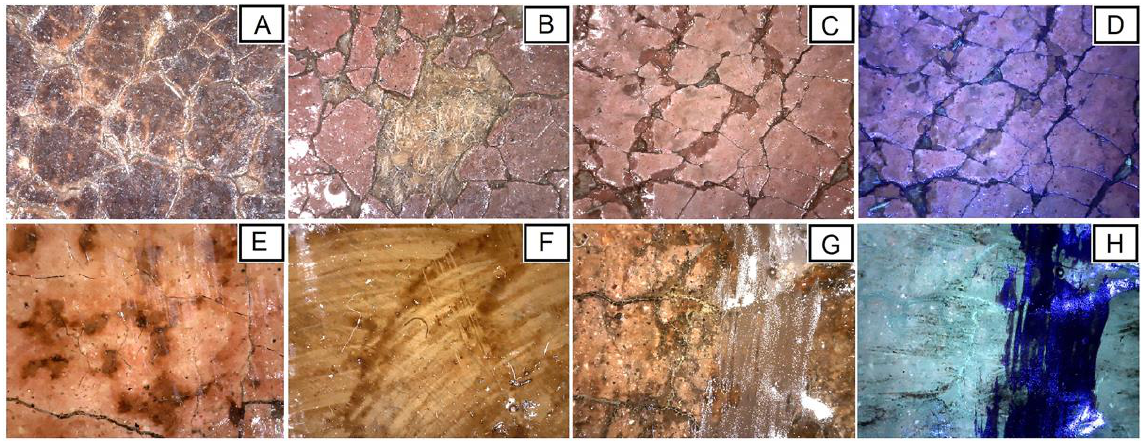
Figure 3. Digital optical microscopy images on selected areas of Painting 1 ( A – D ) and Painting 2 ( E – H ). ( A , B ): areas of the original painting, where the reddish-brown ground is also evident in some portions affected by thinning, and the original canvas is visible in correspondence of a lacunae; ( C ): the large fractures of the craquelure are retouched with thin pictorial integrations evident even under UVF ( D ); ( E , F ): original painting with traces of both original and non-original superficial protective varnish. In particular, the darker portions (brown) in ( F ) are attributable to residues of the original protective layer (solubilized and not completely removed before the application of the current thick layer of protective varnish); ( G , H ): area showing both original and non-original pictorial brushstrokes. The repainting visible on the right side of both images is accentuated above all in H through the use of UV (dark area).